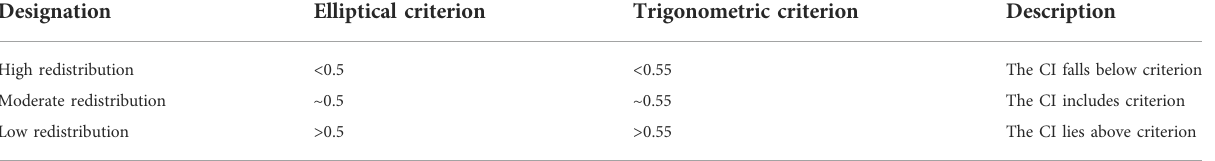
TABLE 1 Pressure redistribution classi fi cation de fi